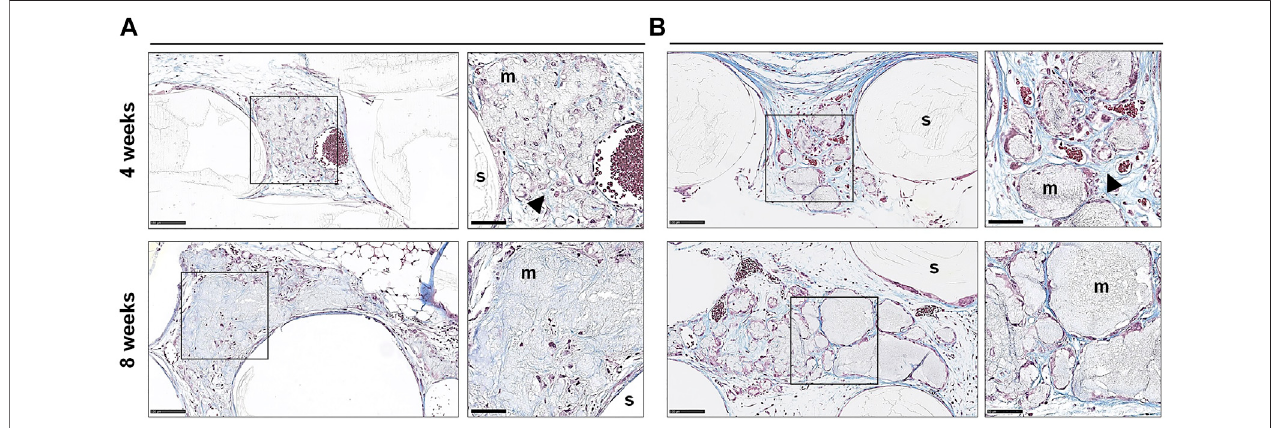
FIGURE 6 | Histology of cell-free constructs. Representative images of Trichrome stained sections of cell-free constructs showing different patterns of mineralization (A,B) after 4 and 8 weeks; m, mineralization; s, scaffold; arrows indicate dense collagen; scale bars 100 μ m (20x) and 50 μ m (40x).